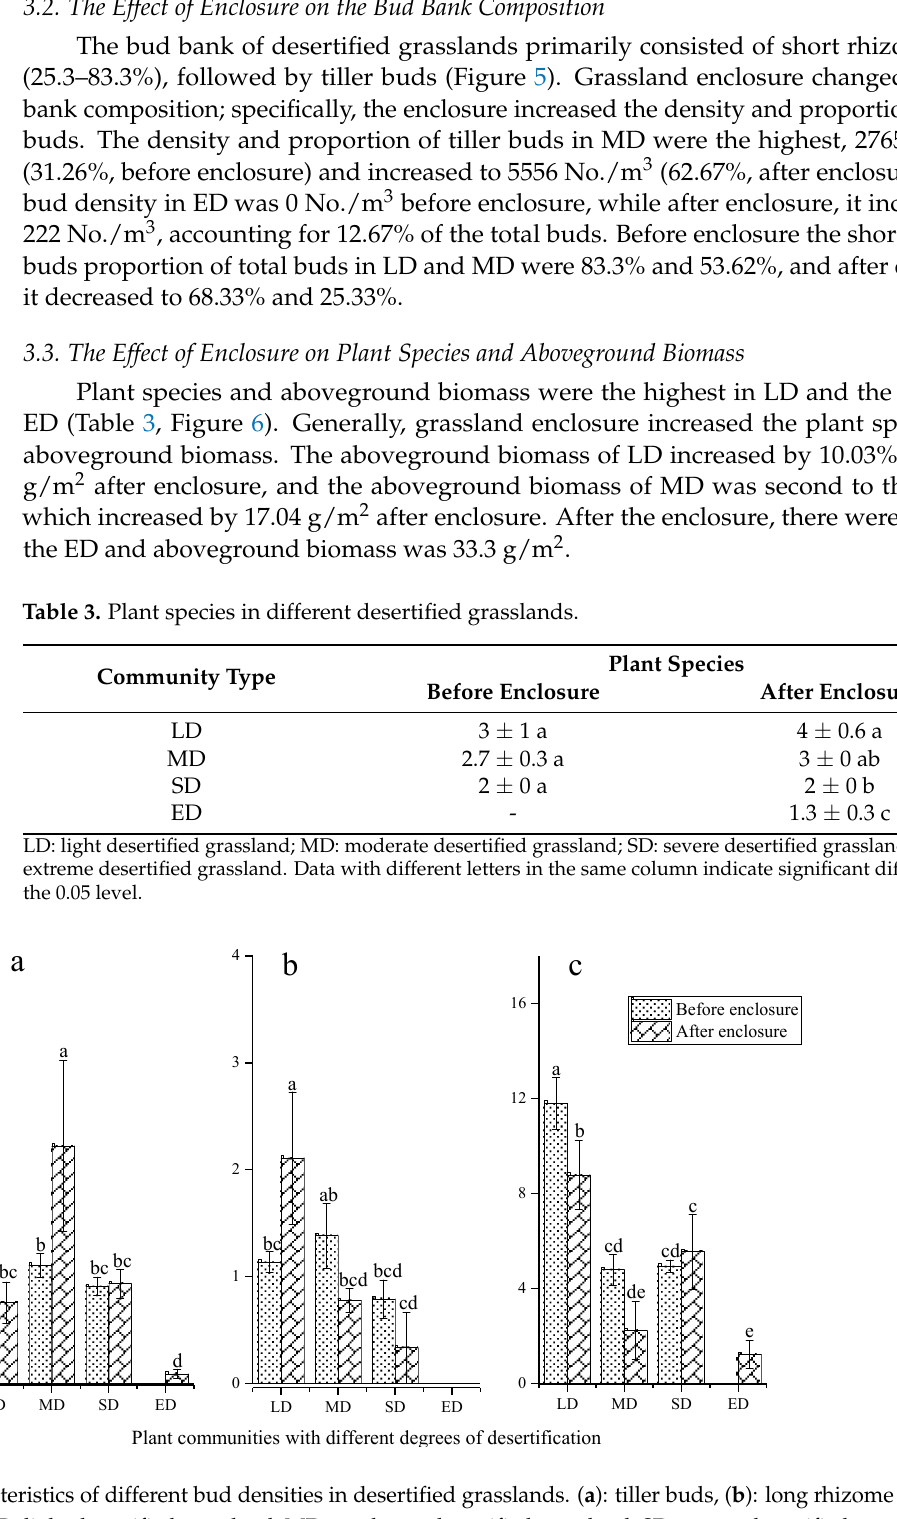
Figure 5. Variation characteristics of different bud densities in desertified grasslands. ( a ): tiller buds, ( b ): long rhizome buds, ( c ): short rhizome buds. LD: light desertified grassland; MD: moderate desertified grassland; SD: severe desertified grassland; and ED: extreme desertified grassland. Data with different letters in the same column indicate significant differences at the 0.05 level.